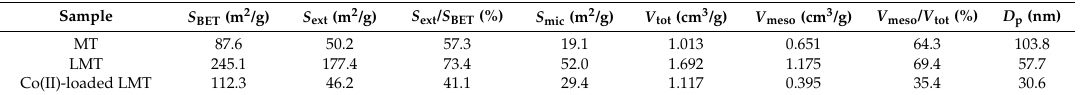
Table 1. Pore structure parameters of MT, LMT nanocomposite and Co(II)-loaded LMT used in this